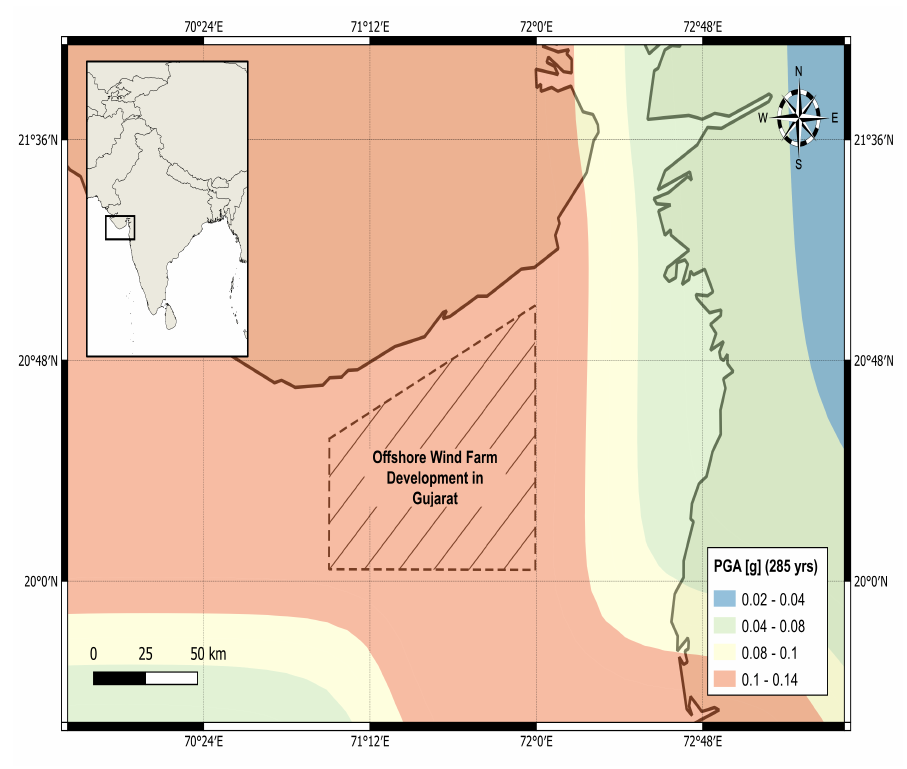
Figure A2. Seismic hazard map for